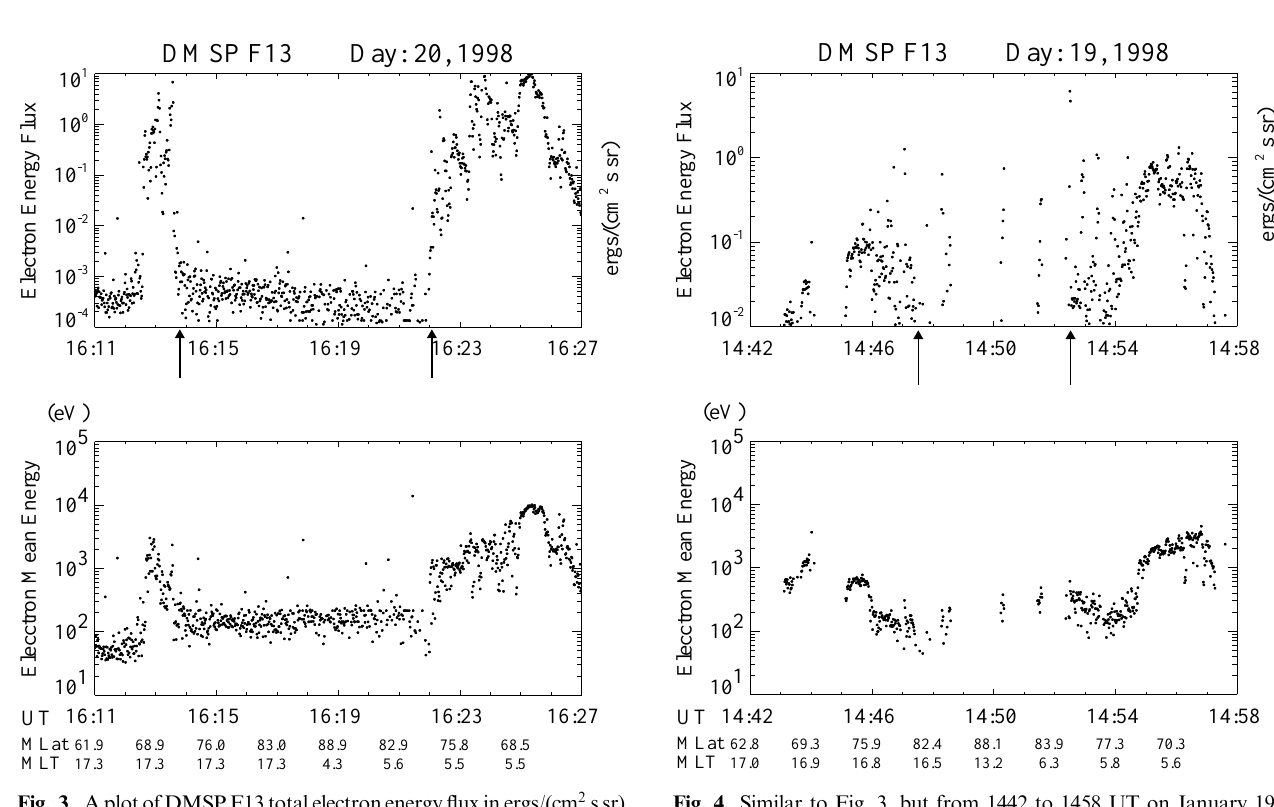
Fig. 2. Plots of IMF B x , B y , B z , solar wind density ( N ) and x -component ( V x ) of the solar wind speed from January 19 to 22, 1998